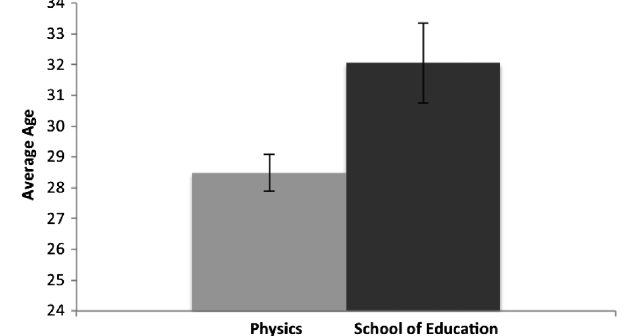
FIG. 7. Average age of PER graduate students in physics departments and schools of education (with error bars represent- ing the standard error of the mean).